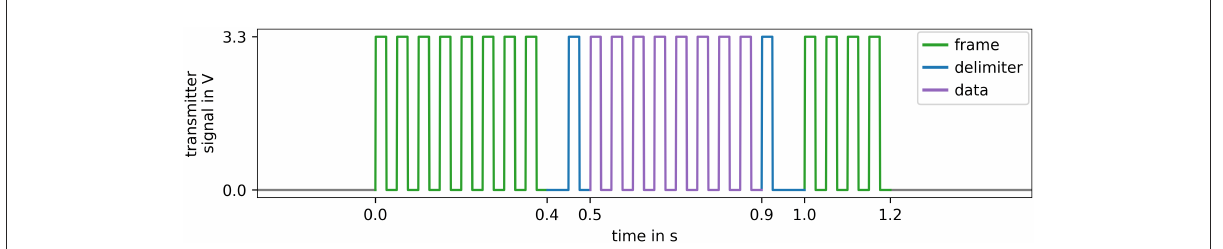
FIGURE2 Simulated, synthetic illustration of the signals at the transmitter: 8 pulses preamble (green), gap and pulse as delimiter (blue), 8 pulses or gaps to encode the data in OOK scheme (violet) with the MSB first, pulse and gap as delimiter (blue), and 4 pulses terminator (green). Modulation frequency f 0 of 20Hz.